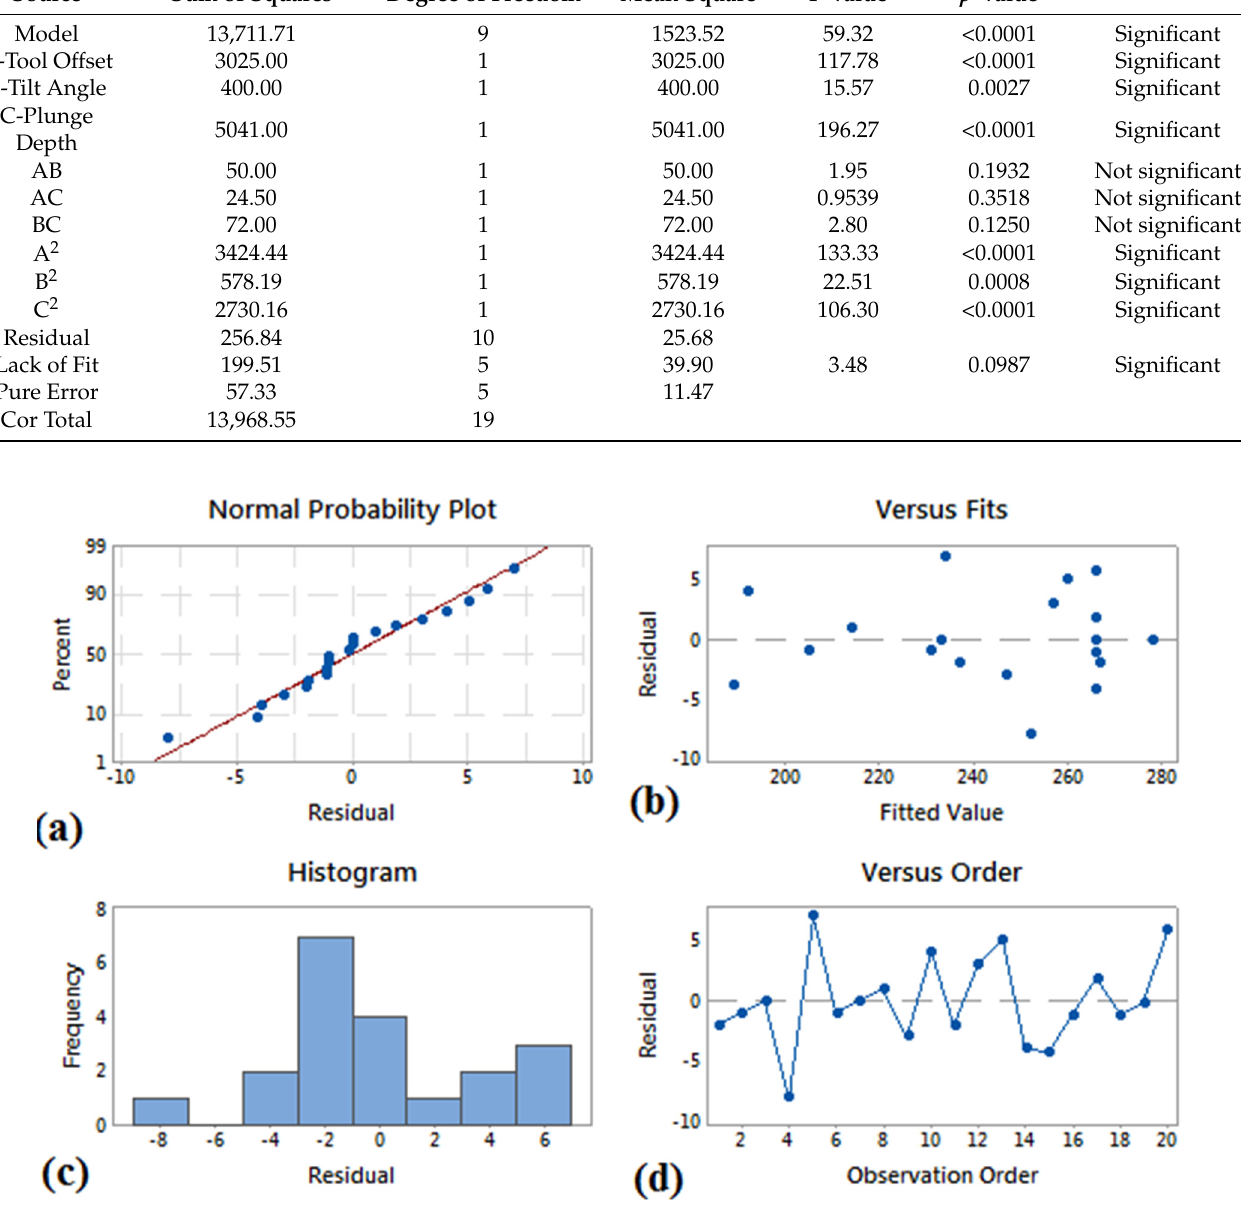
Figure 4. Evaluation results of statistical model ( a ) Residual-percent, ( b ) fitted value-residual, ( c ) residual-frequency, and ( d ) observation order-residual.